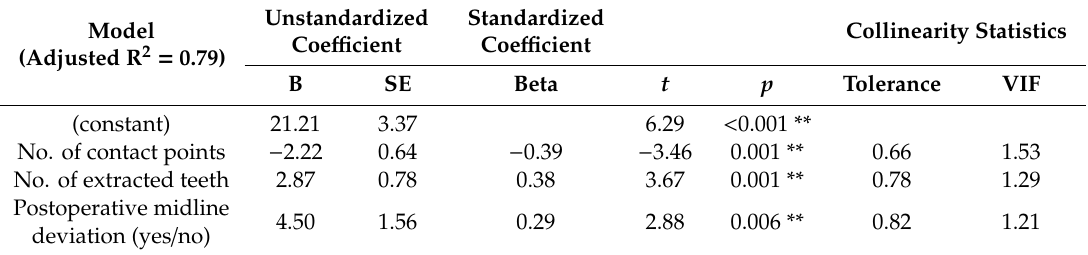
Table 3. Total treatment time prediction regression model through multiple regression analysis.